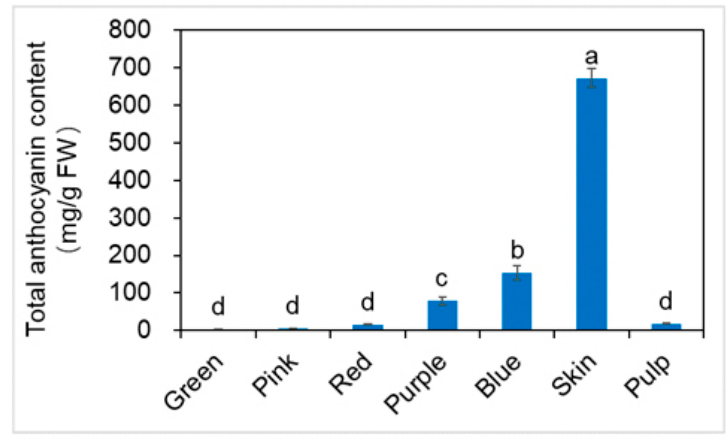
Figure 3. Changes of the contents of total anthocyanin for blueberry different developmental stages of fruit, skin and pulp (mean ± SD, n = 3). Bars with different letters differ significantly ( p < 0.05). These results indicated that TFC, TPC and TAC of blueberry are mainly present in the skin.